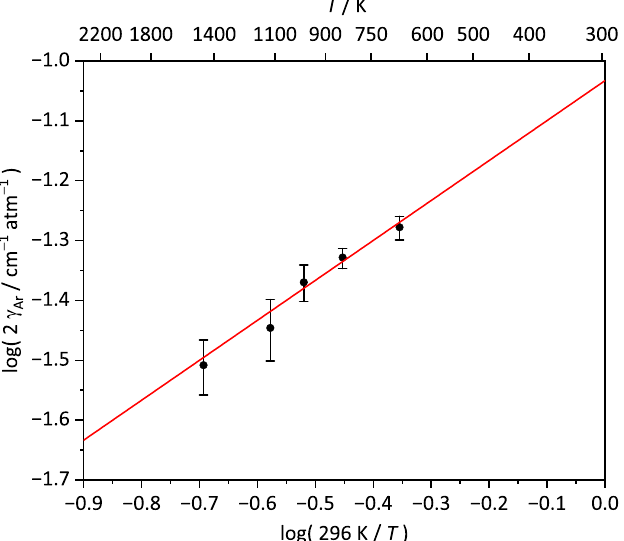
Figure 3. log-log plot for the temperature dependence of the argon broadening coefficient 2 γ Ar . Experimental data (black symbols) including errors estimated from the Voigt fits and a linear fit according to Equation (3) (red